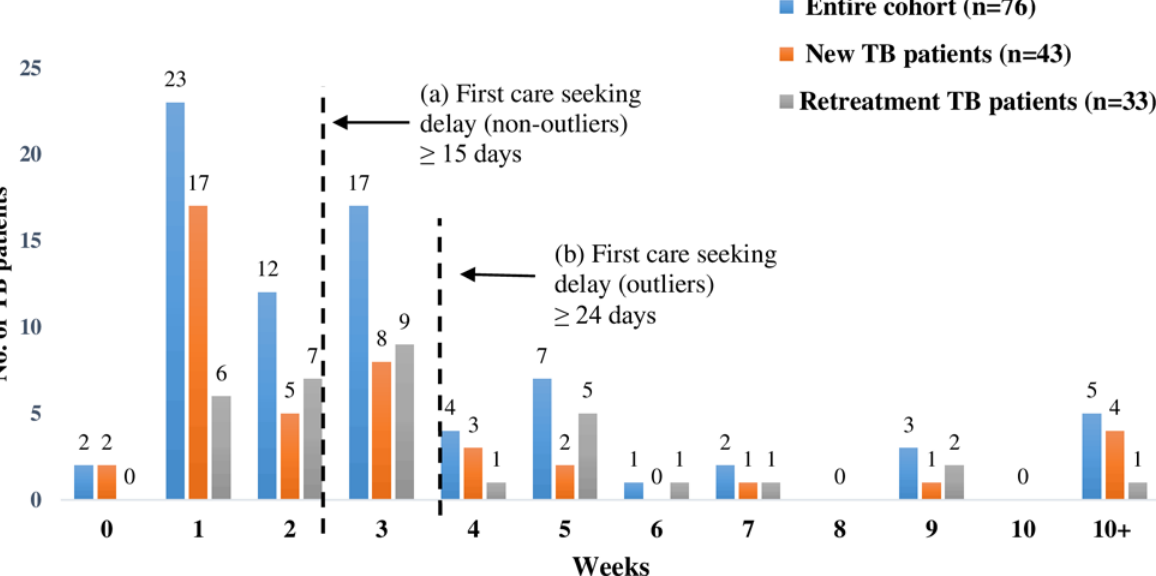
Fig 2. First Care Seeking: Duration and Delays. The figure represents the time taken from onset of symptoms suggestive of TB to first contact with any health care provider. The serrated lines depict the durations that reflect (a) delay and (b) outliers. doi:10.1371/journal.pone.0152287.g002 PLOS ONE | DOI:10.1371/journal.pone.0152287 March 28,